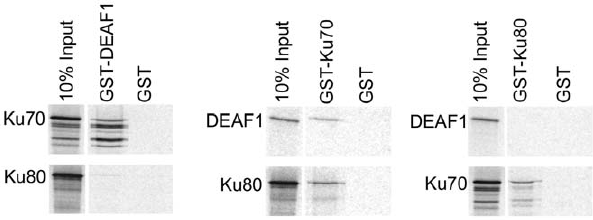
Figure 2. DEAF1 interacts with Ku70. GST pull-downs assays were performed by incubation of in vitro translated, [ 35 S]methionine-labeled Ku70, Ku80, or DEAF1 with the indicated GST fusion proteins and GST. 10% of the in vitro translated proteins used in the pull-downs are shown on the left of each panel. The results are representative of two independent